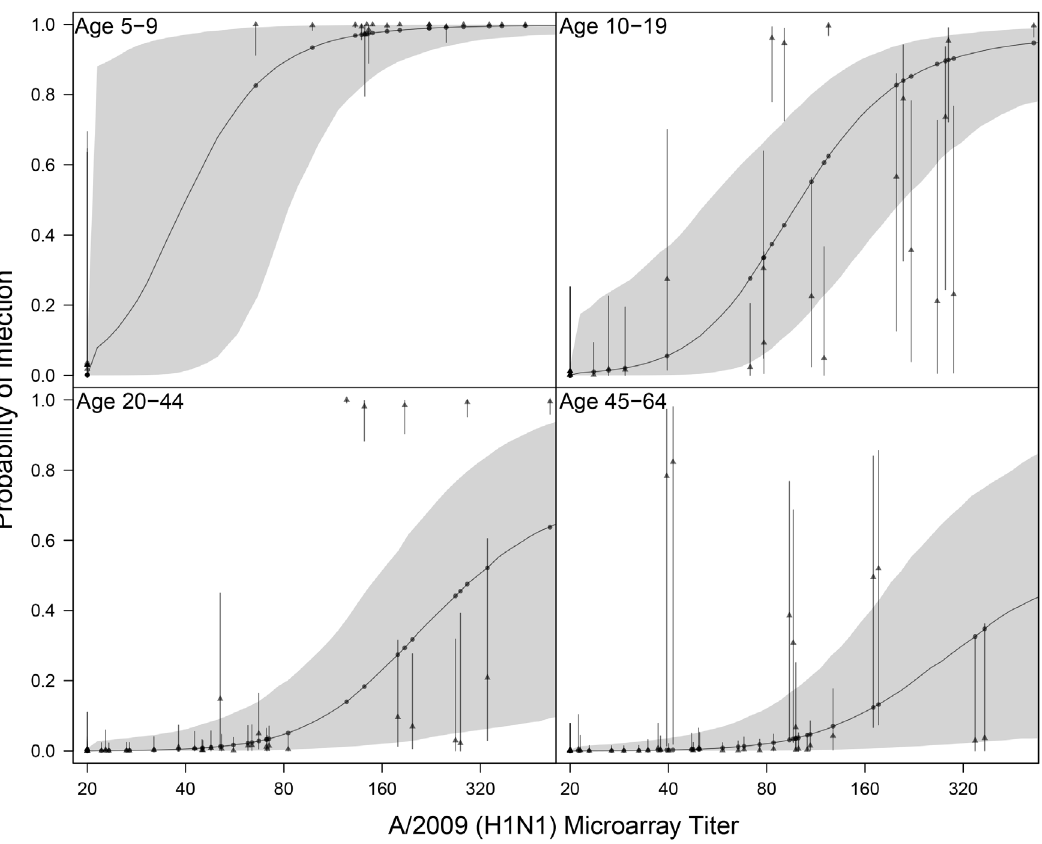
Figure 4. Classification of sera in the uni- and bivariate mixture analyses as a function of the microarray response to A/2009 (H1N1). Shown are the estimated probabilty of infection in the univariate mixture (dots and solid line) with associated 95% confidence envelope (shaded area), and for each sample the corresponding estimates in the bivariate mixture (triangles) with associated 95% confidence intervals (bars).